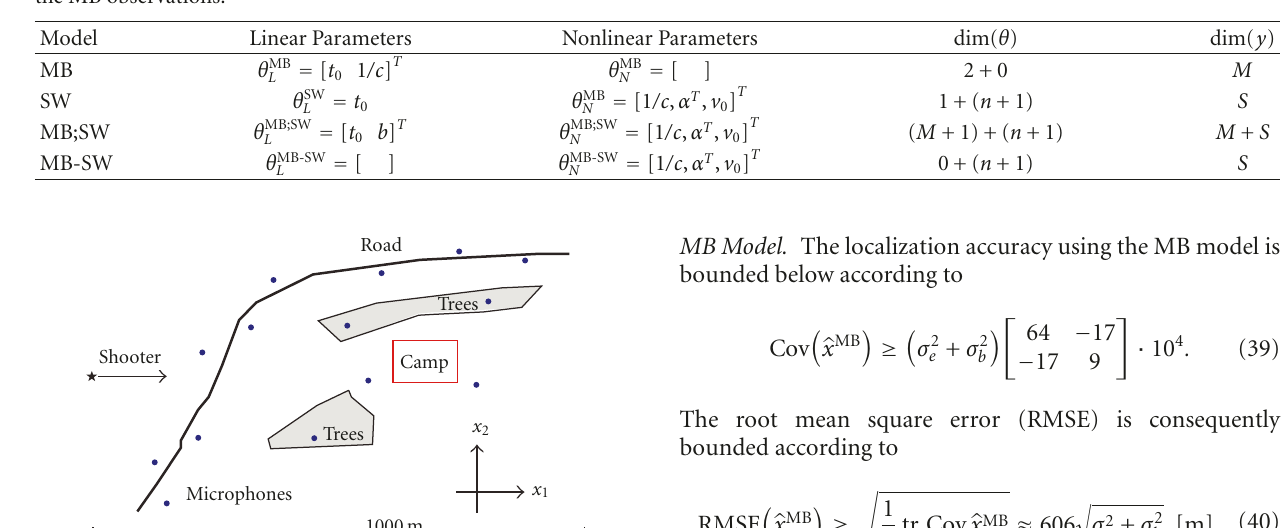
Table 2: Summary of parameter vectors for the di ff erent models y = h L ( θ N ) θ L + h N ( θ N ) + e , where the noise models are summarized in (29a), (29b), (29c), (29d), and (29e). The values of the dimensions assume that the set of microphones giving SW observations is a subset of the MB observations.